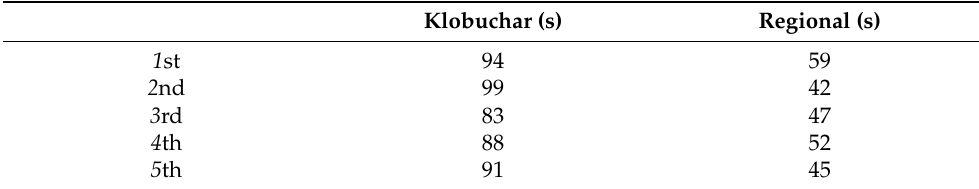
Table 4. Convergence time in elevation direction of